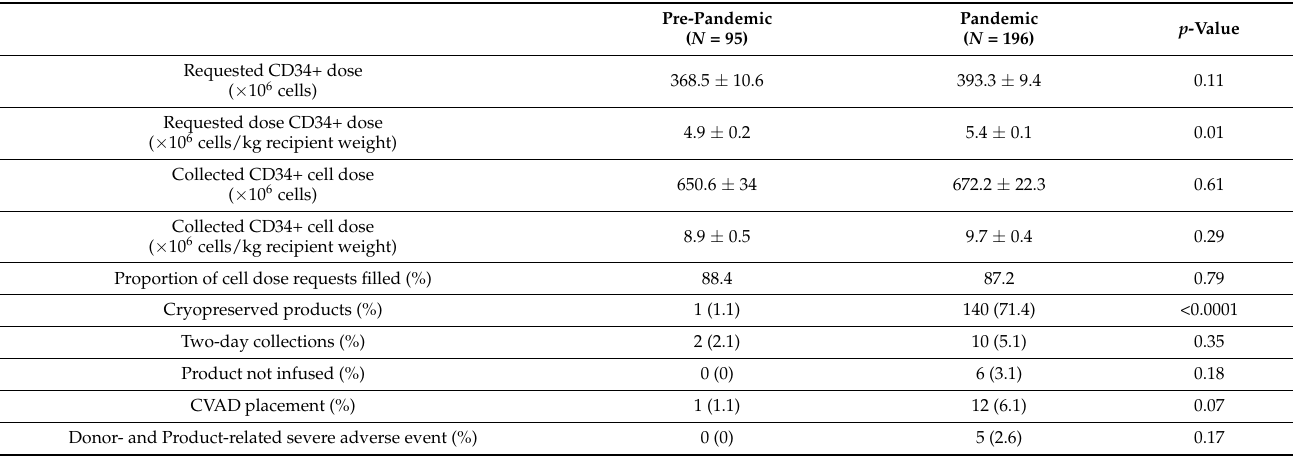
Table 2. Pre-Pandemic and Pandemic Allogeneic PBSC Collection